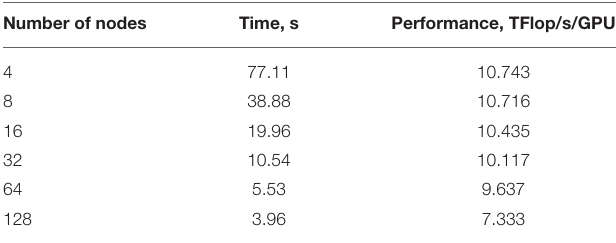
TABLE 2 | Convergence of the ground state correlation energy with respect to the maximal bond dimension for the AIEM Hamiltonian describing a combined system of 48 2-level chemical